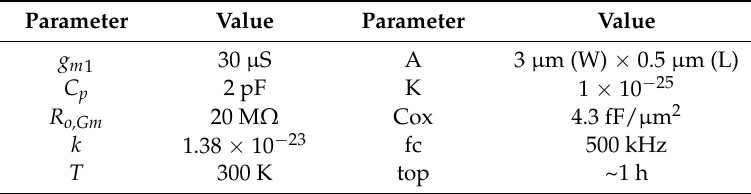
Table 1. Device parameter used for the noise estimation.